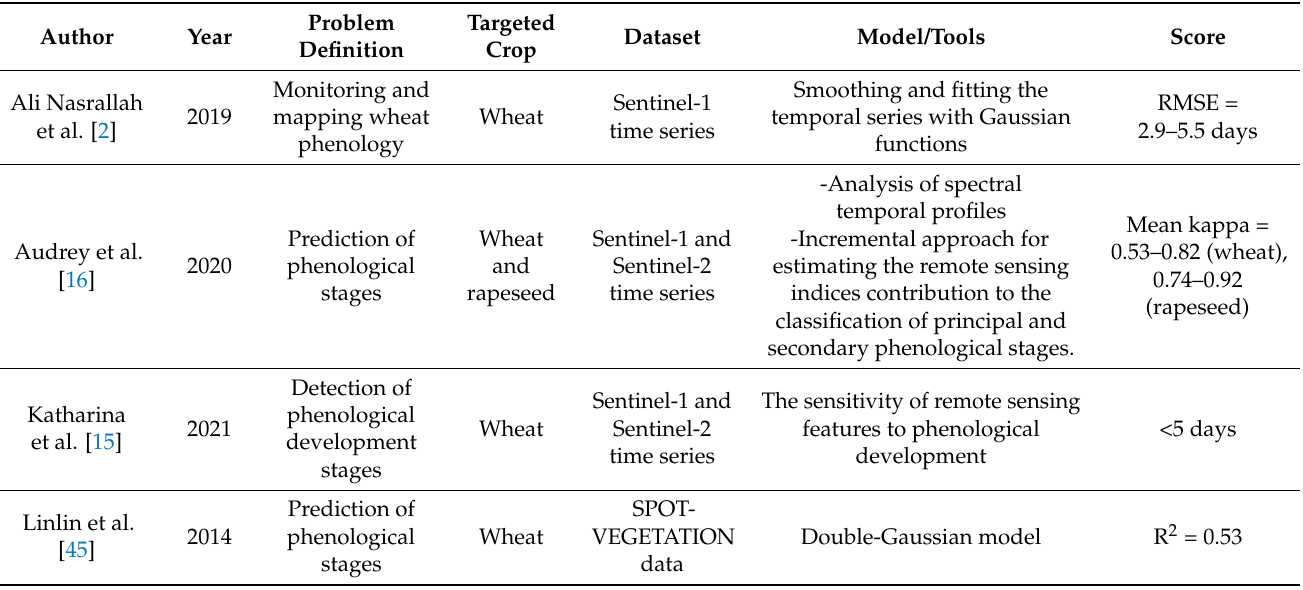
Table 8. Overview of recent works results on the monitoring of the phenological stages of wheat using Sentinel-1 and Sentinel-2 remote sensing